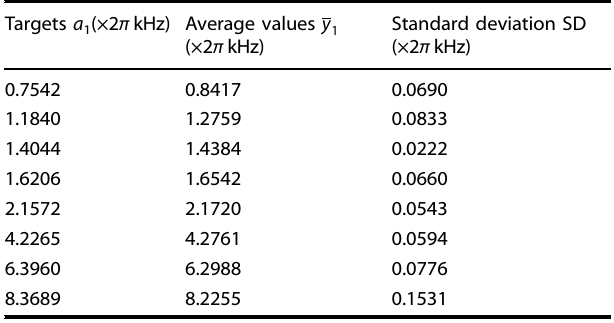
Table 2. Estimation results from the NN in Scenario